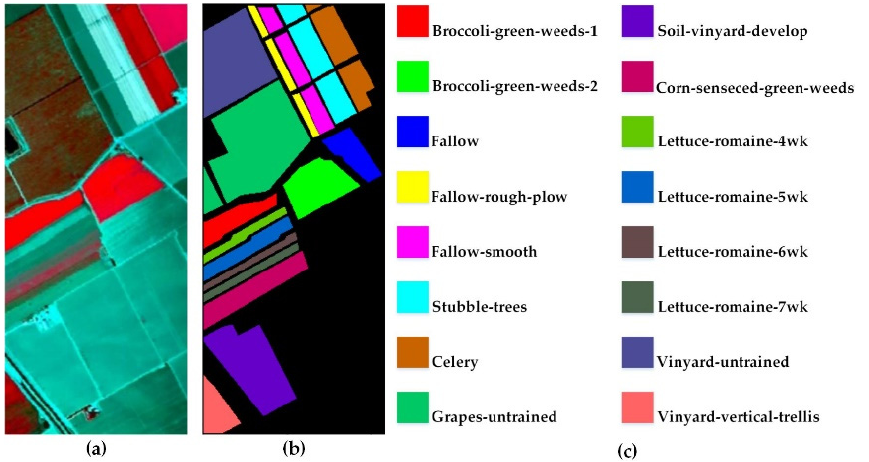
Figure 8. The IP dataset. ( a ) False-color image, ( b ) Ground-truth image, ( c ) Labels.